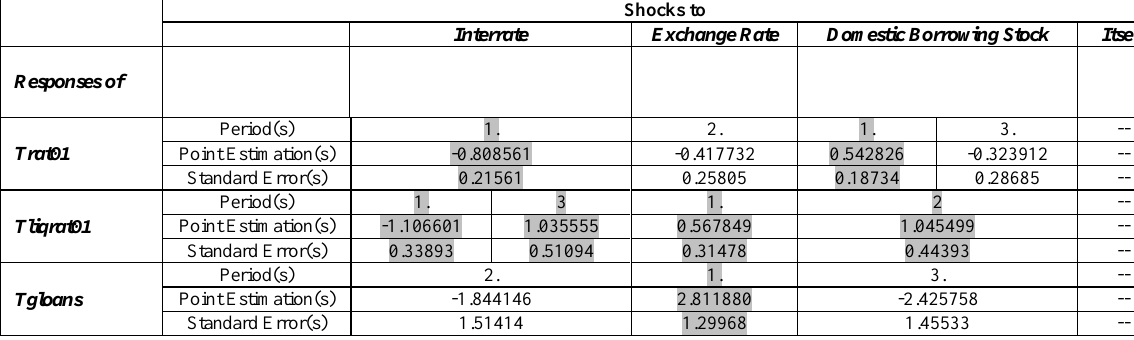
Table 4. The Summary of the IRFs of TBS (Including Foreign Banking Group)